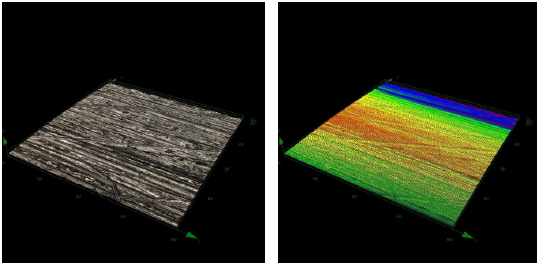
Figure 4. Microscopic image of abraded Inconel 625 tube